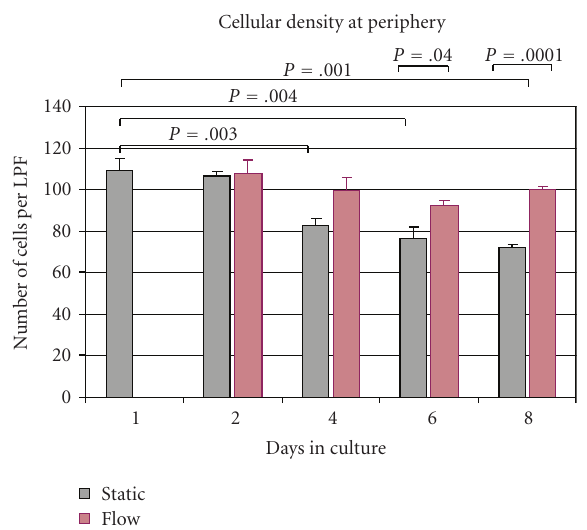
Figure 3: Static cultured sca ff olds had a 34% reduction in cellular viability at the periphery over the experimental period. In contrast, dynamic culture resulted in an 8.3% decrease in cell